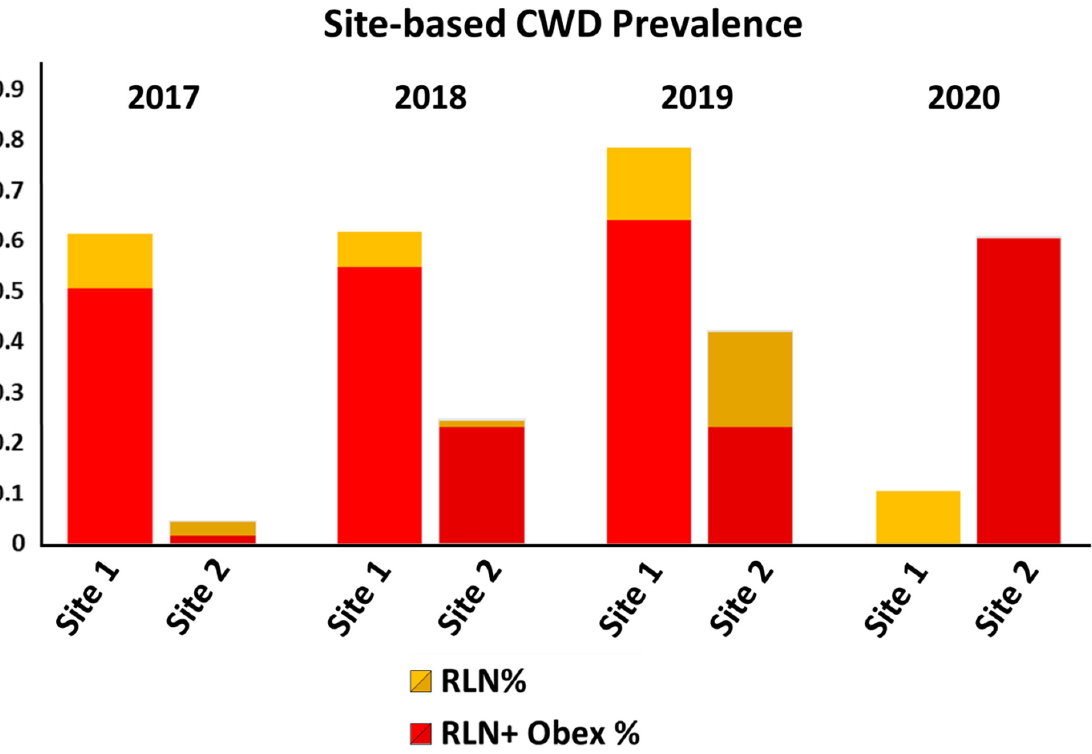
Figure 5. Prevalence of CWD on hunting sites 1 and 2 over the course of the study. Prevalence steadily increased on site 1 over the first phase of the project, followed by an abrupt drop with the initiation of study phase 2 (2020) and the introduction of animals with resistant PRNP genotypes. Prevalence likewise increased on site 2 through the initiation of study phase 2, when our initial plans for in situ genotypic shifts were modified to allow for complete depopulation of the site prior to introducing animals with resistant genotypes, mirroring objectives for site 1. Data from hunting premises 3, which has to date remained CWD-negative, are not included in the figure.